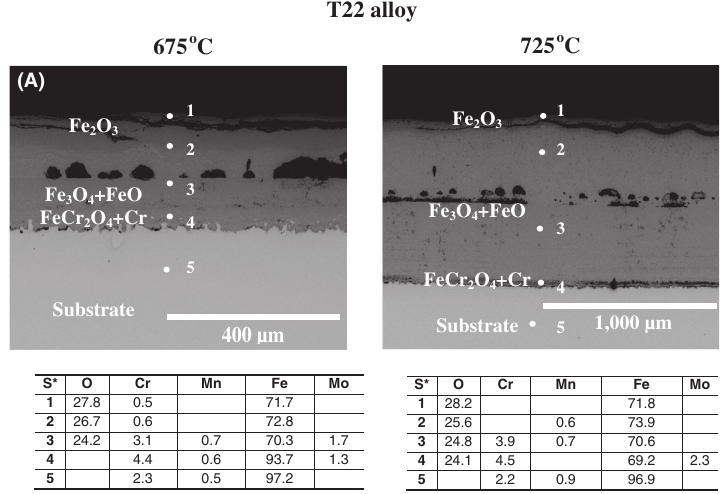
Figure 7: A comparison of the cross-sectioned samples: after 500-h exposure at 675°C and 725°C: (A) T22, (B) T23, (C) TP347HFG, (D) HR3C and (E) 718 þ .